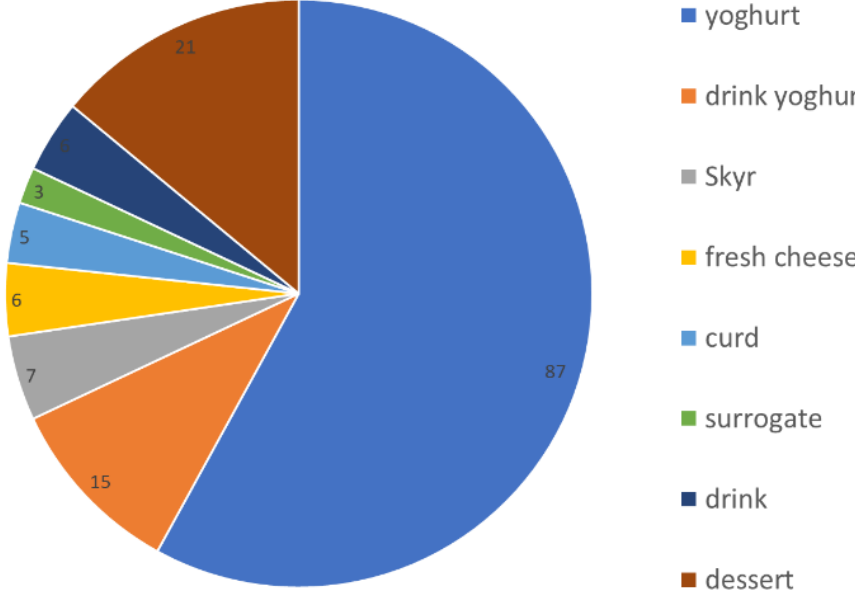
Figure 2. Analysed product categories; numbers: number of samples, n = 150 .